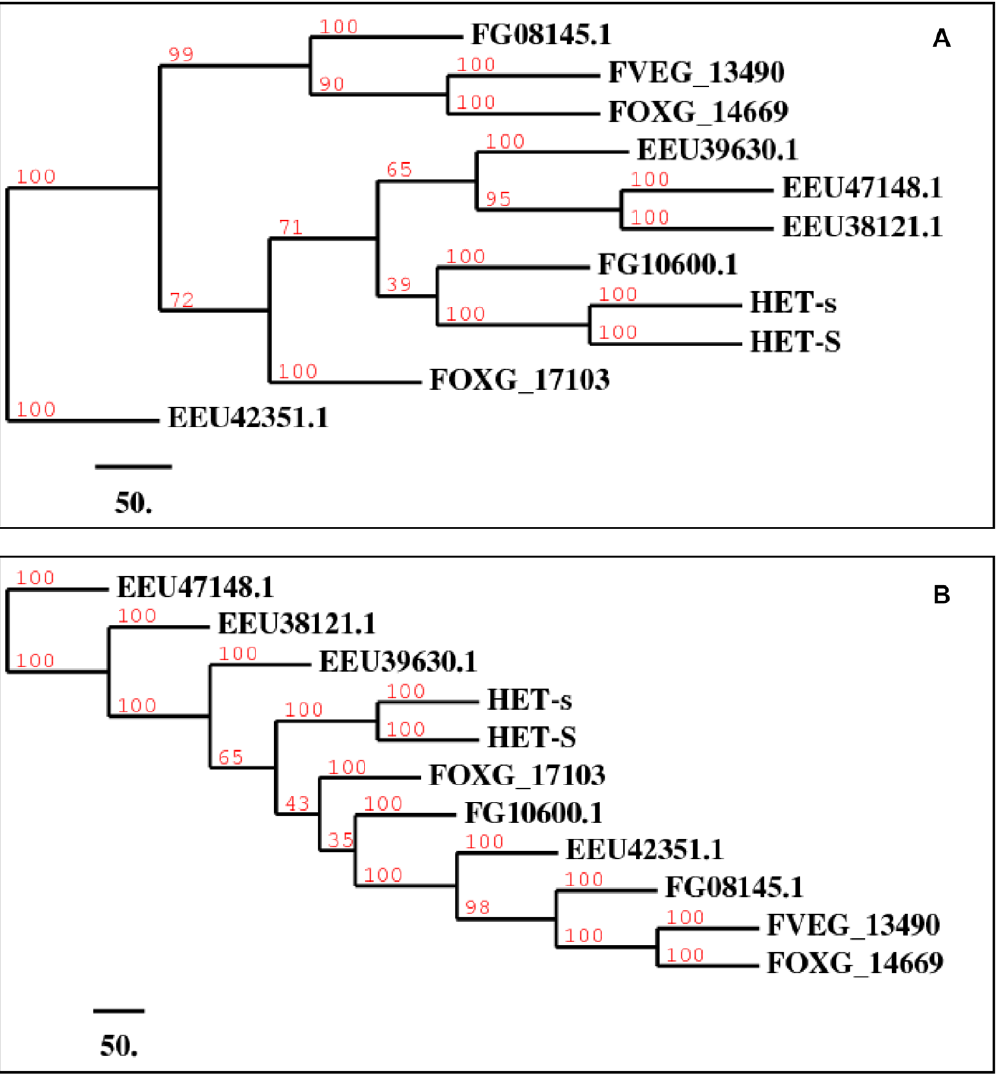
Figure 3. Phylogenetic trees of homologs to the HET-s prion-forming and N-terminal domains. A) Phylogenetic tree of homologs to the HET-s prion-forming domain. B) Phylogenetic tree of homologs to the HET-s N-terminal domain. The generated trees are neighbor- joining majority-rule consensus trees composed of 11 sequences. Sequences starting with EEU represent Nectria haematococca mpVI 77-13-4, FOXG represent Fusarium oxysporum f. sp. lycopersici, FVEG represent Fusarium verticillioides ( Gibberella moniliformis ), and FG represent Fusarium graminearum ( Gibberella zeae ). Branch numbers indicate the number of times the partition of the species into two sets which are separated by that branch occurs among the trees, out of 100 trees, as described by Phylip consense program [33].